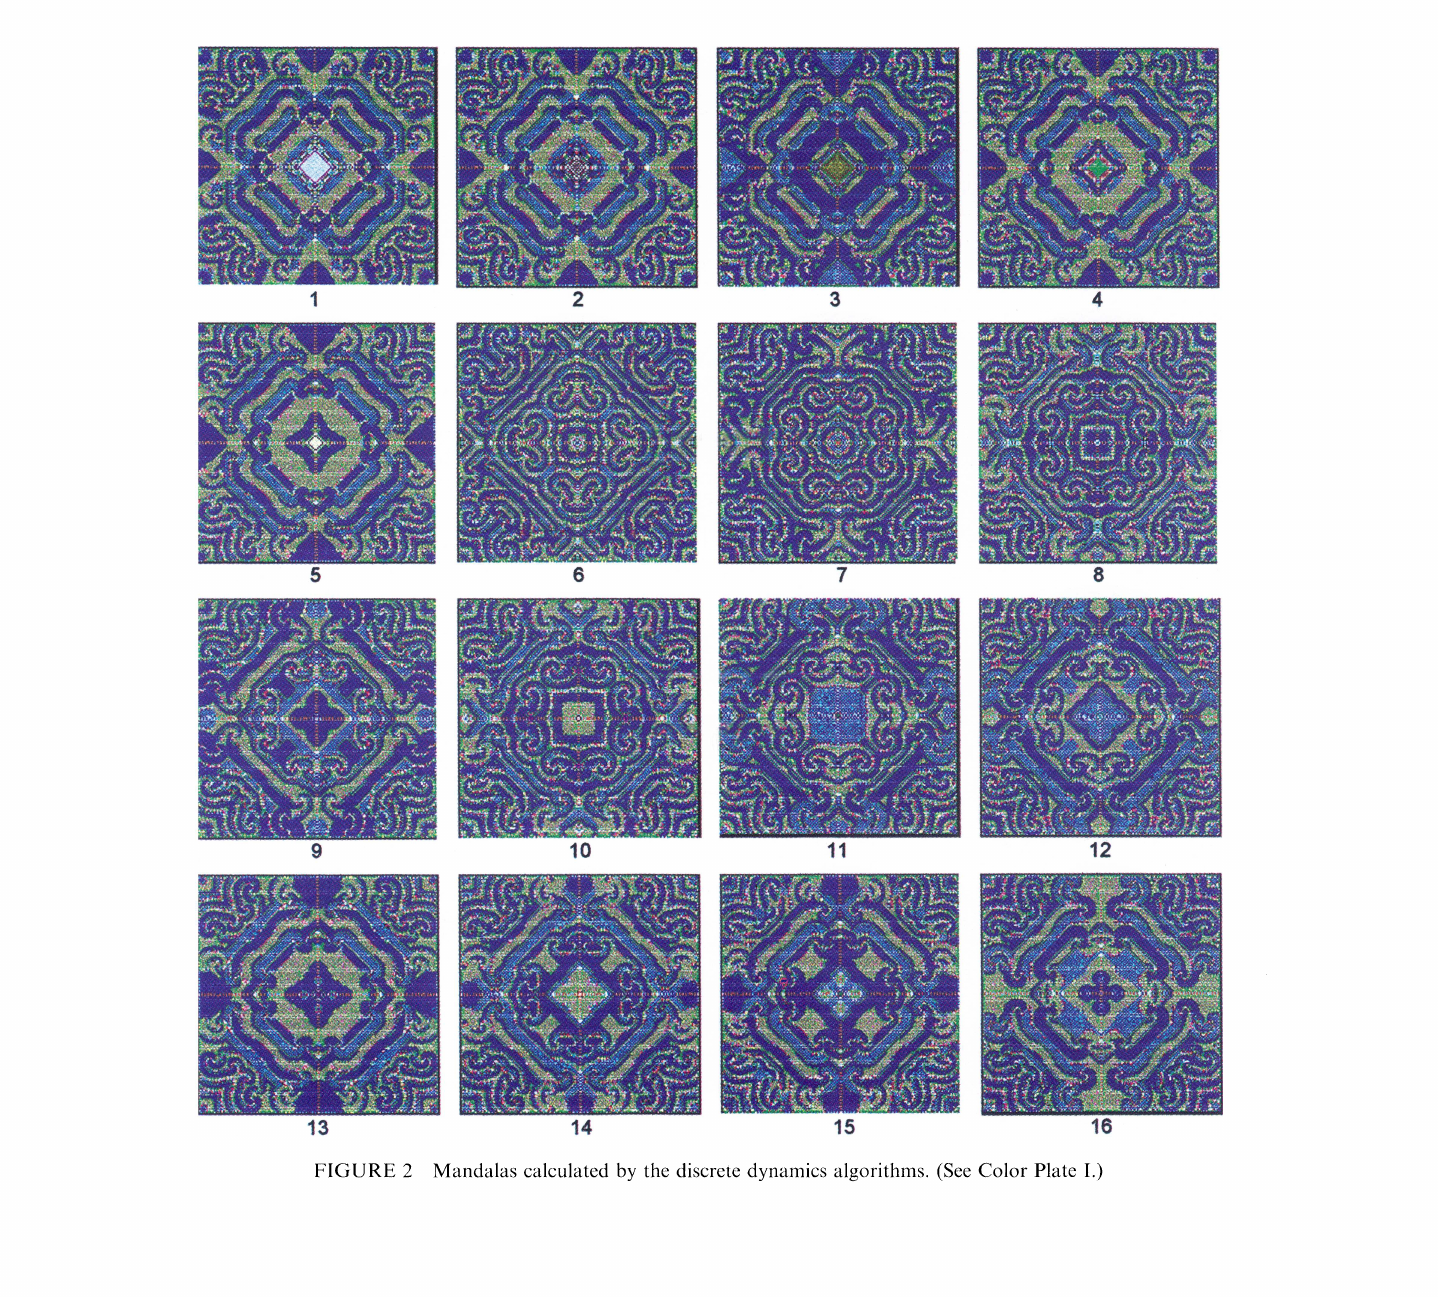
FIGURE 2 Mandalas calculated by the discrete dynamics algorithms. (See Color Plate